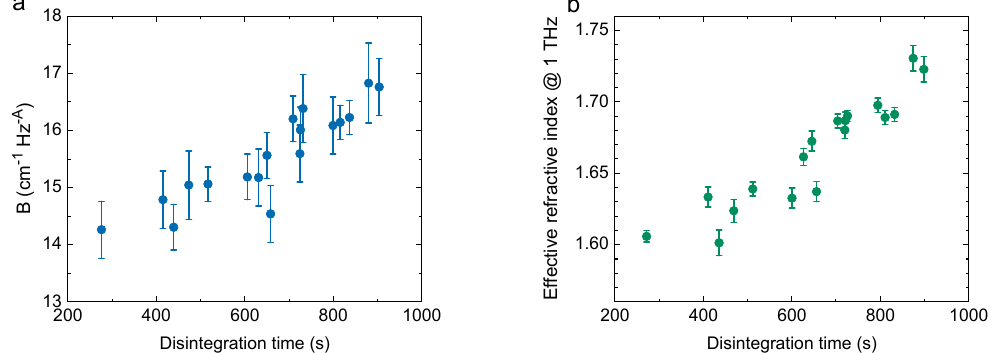
Figure 16. ( a ) Relationship between the loss parameter B and tablet disintegration time. The frequency-dependent scattering loss is described by α eff = B f A (where A ≈ 3.3), therefore the loss parameter B reflects the strength of transmission loss. ( b ) Relationship between effective refractive index and disintegration time. Adapted from [98].